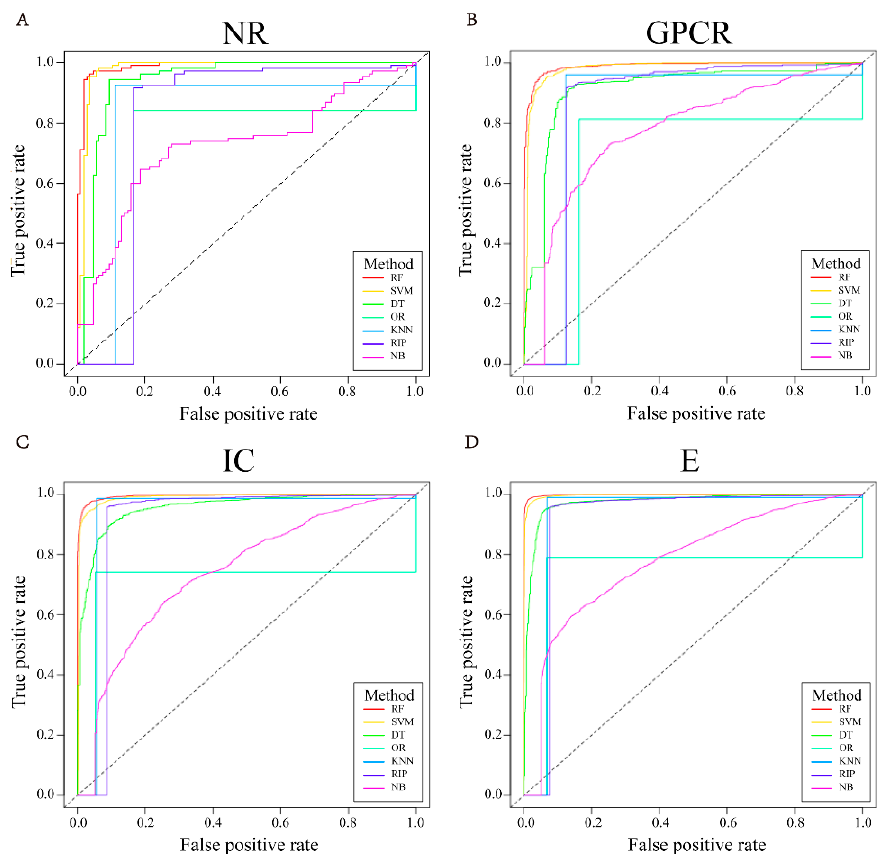
Figure 3. The representative ROC curves of different classifiers in 5-fold cross-validation of four datasets, i.e., NR ( A ), GPCR ( B ), IC ( C ), E ( D ).